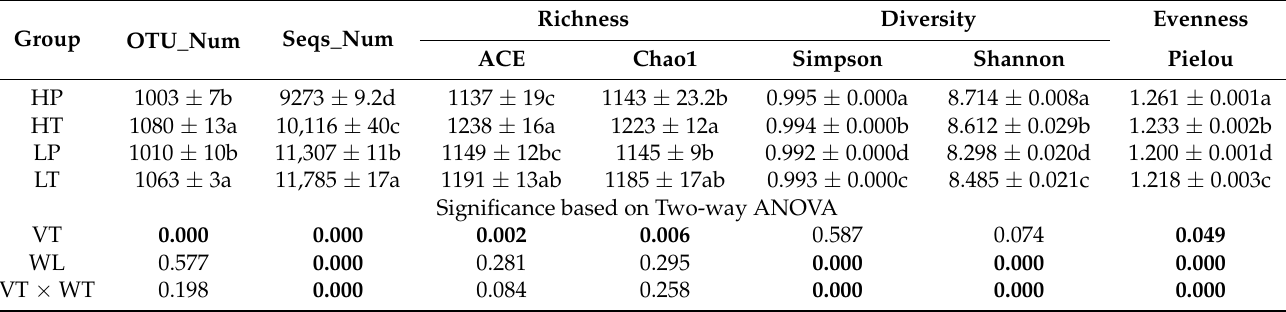
Table 2. The α -diversity index of bacteria in different